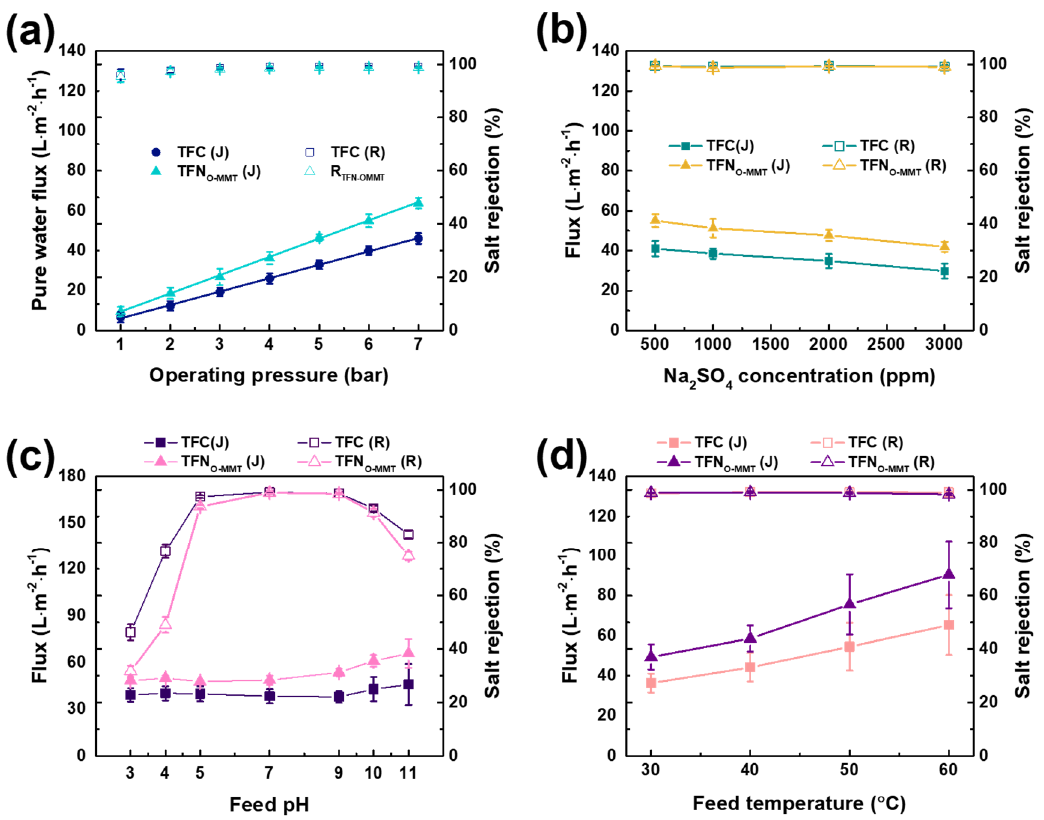
Figure 12. Nanofiltration performance of TFC and TFN O-MMT at different operating conditions: ( a ) operating pressure; ( b ) Na 2 SO 4 concentration; ( c ) feed pH; ( d ) feed temperature. Particle concentration = 0.05 g O-MMT / g TMC.